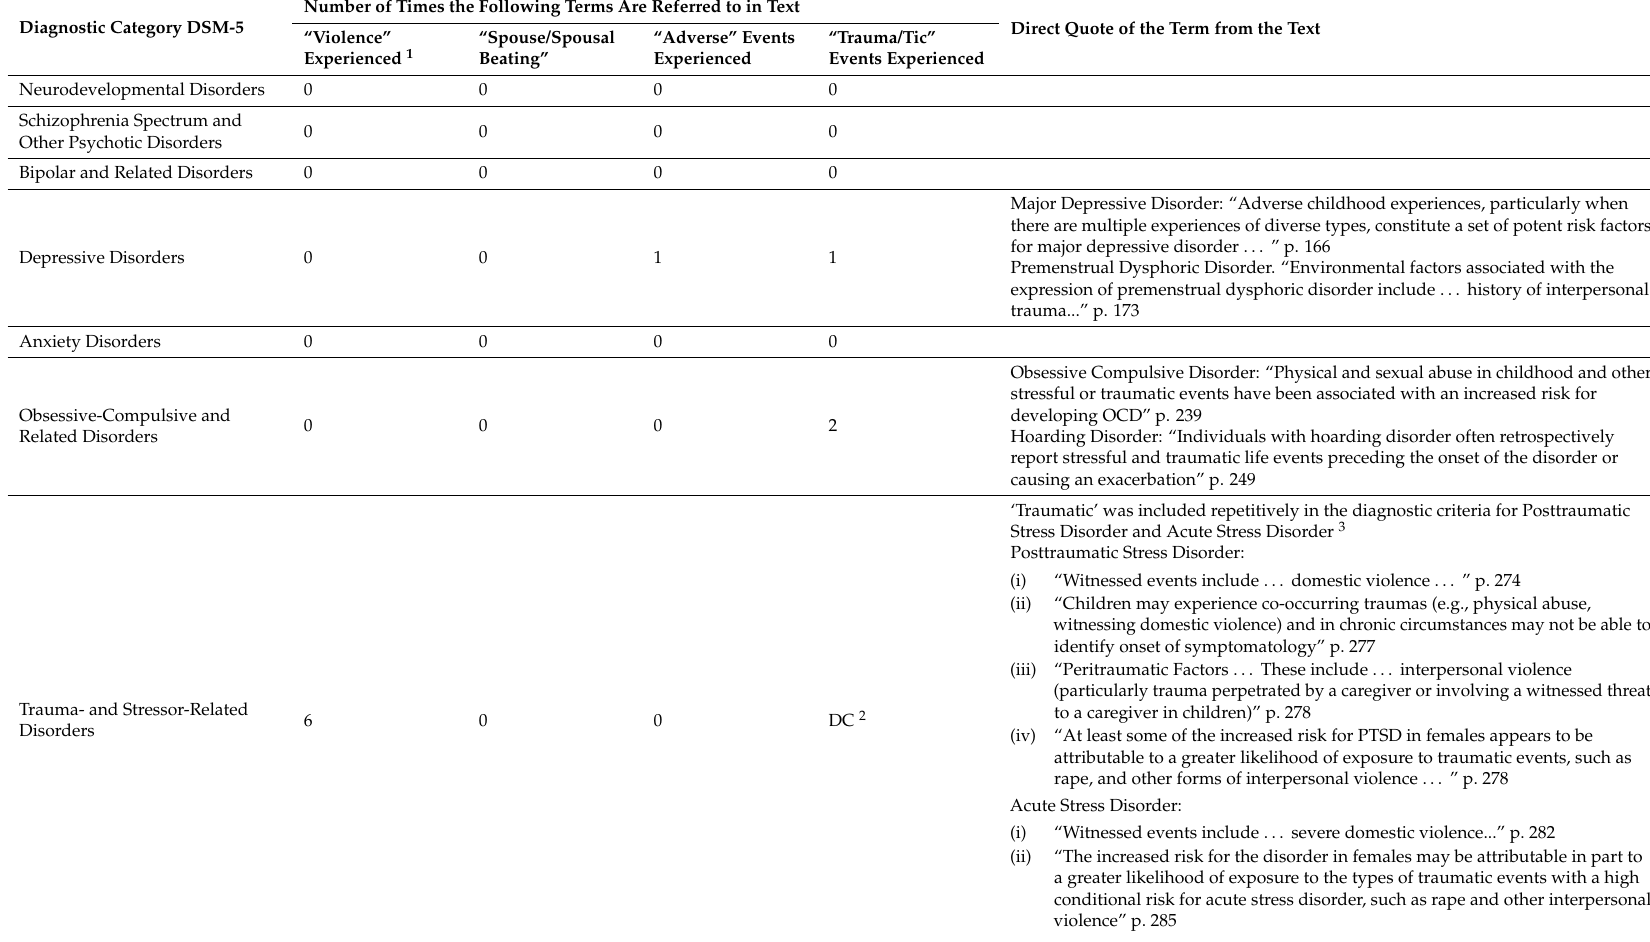
Table 1. Frequency of the terms “family violence”, “domestic violence”, “interpersonal violence”, “partner violence”, “violence”, “spouse/spousal beating”, “adverse” and “trauma/tic” in the context of family violence and events experienced or perpetrated in the DSM 5 Section